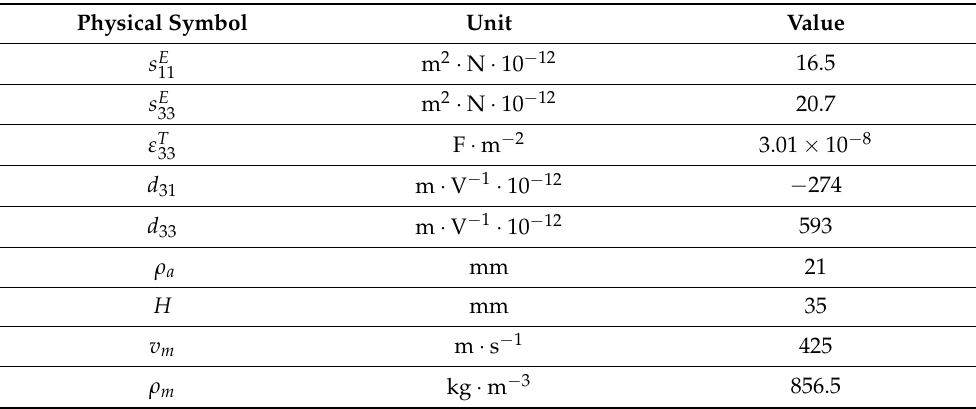
Table 1. The piezoelectric material is the physical parameters of PZT-5H and the geometrical parameters of the